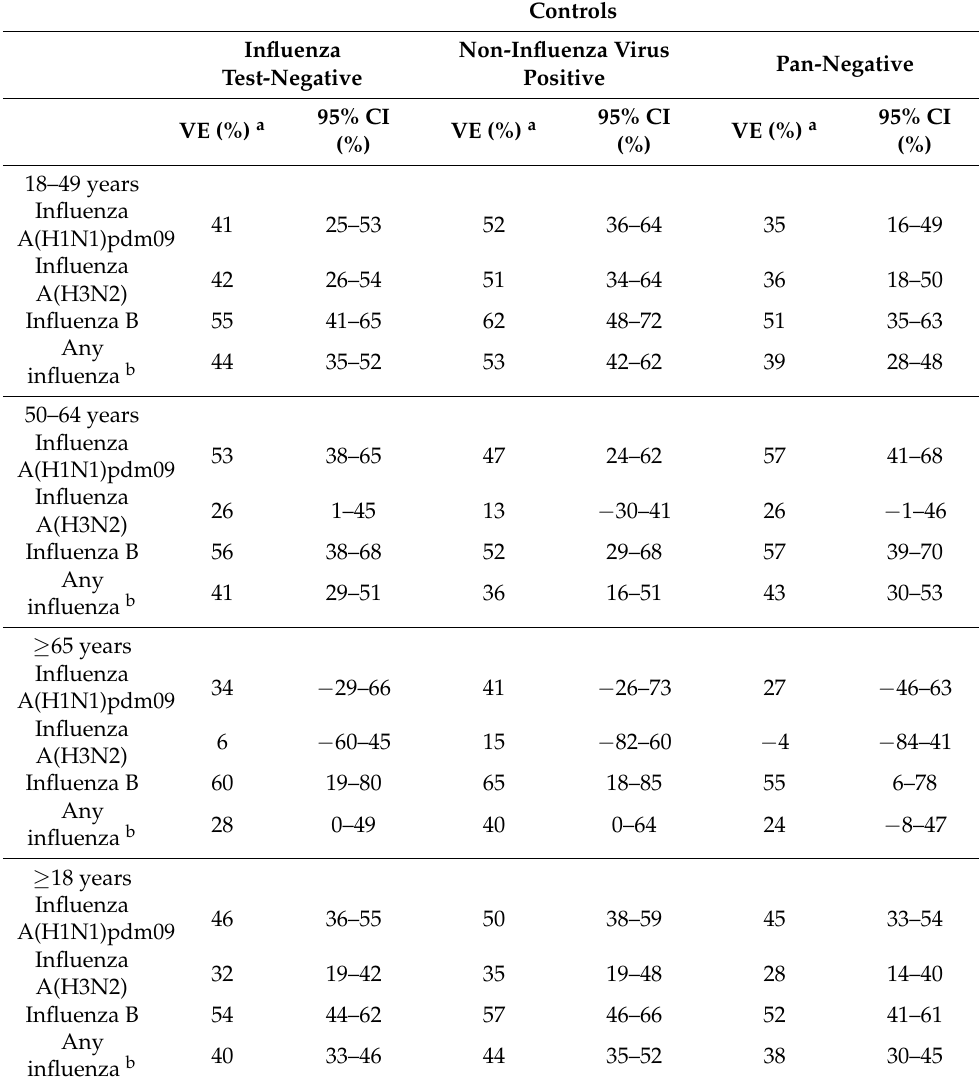
Table 3. Adjusted vaccine effectiveness in adults aged ≥ 18